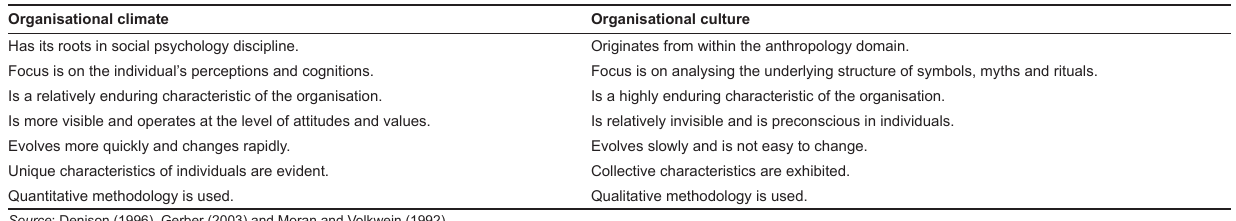
Table 2 Dimensions of organisational